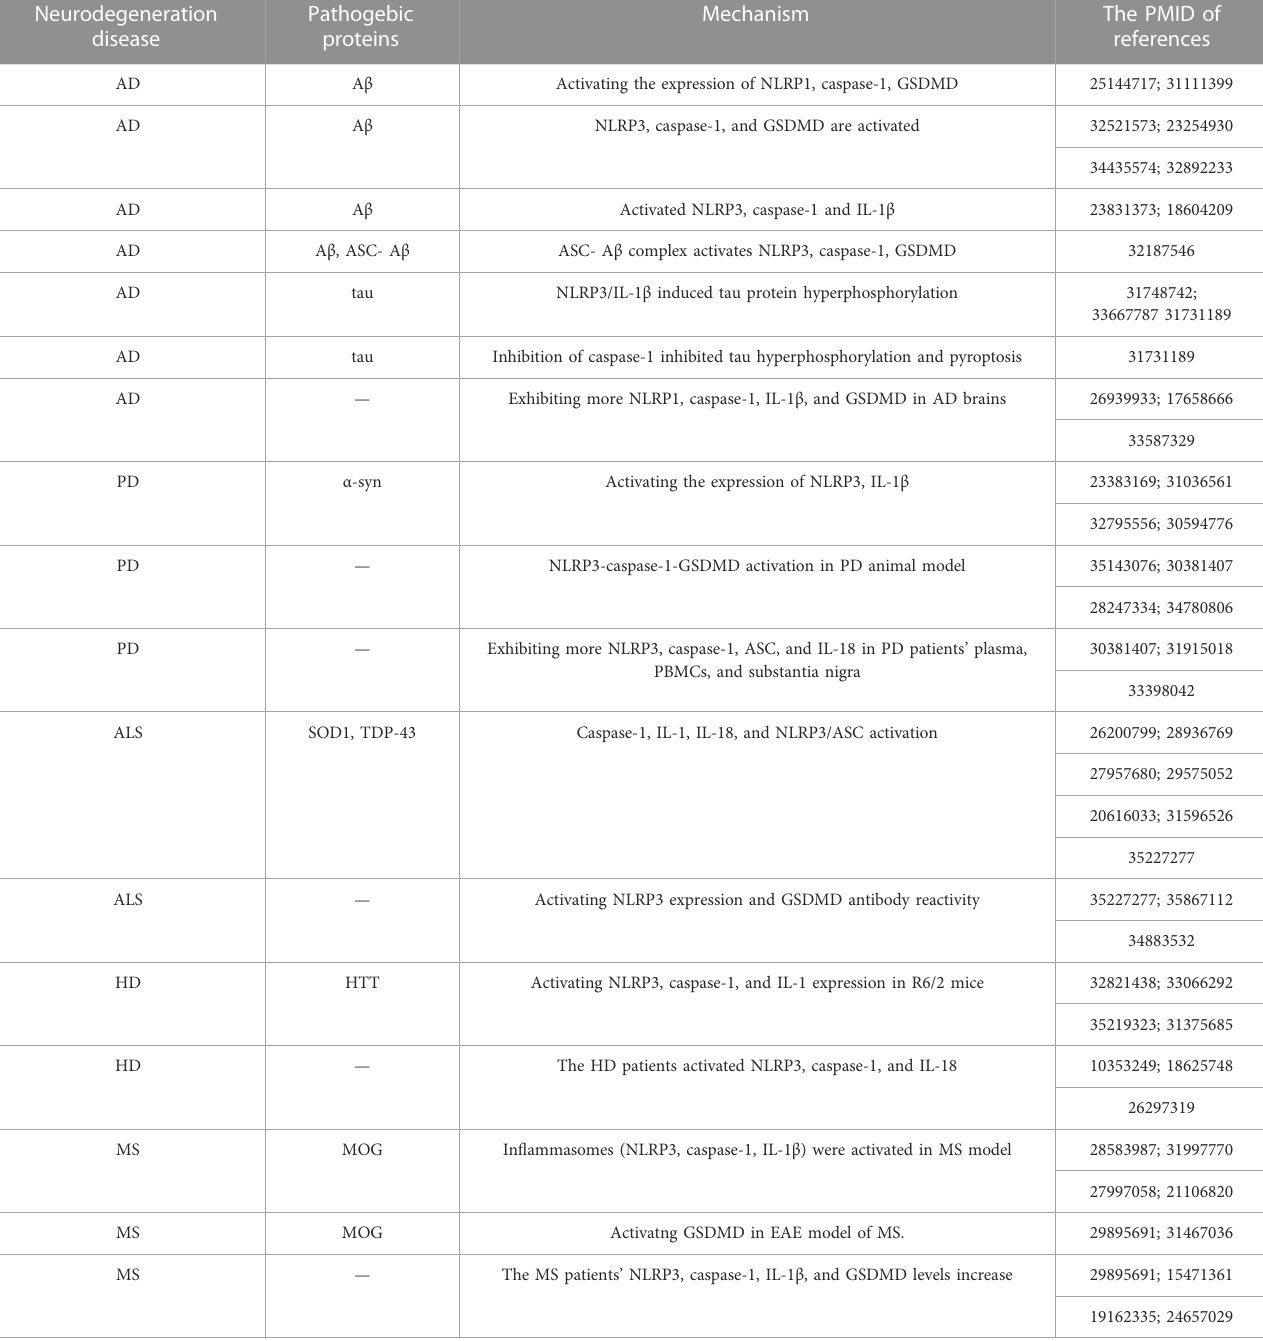
TABLE 1 Evidence for different mechanisms of pyroptosis in neurodegeneration